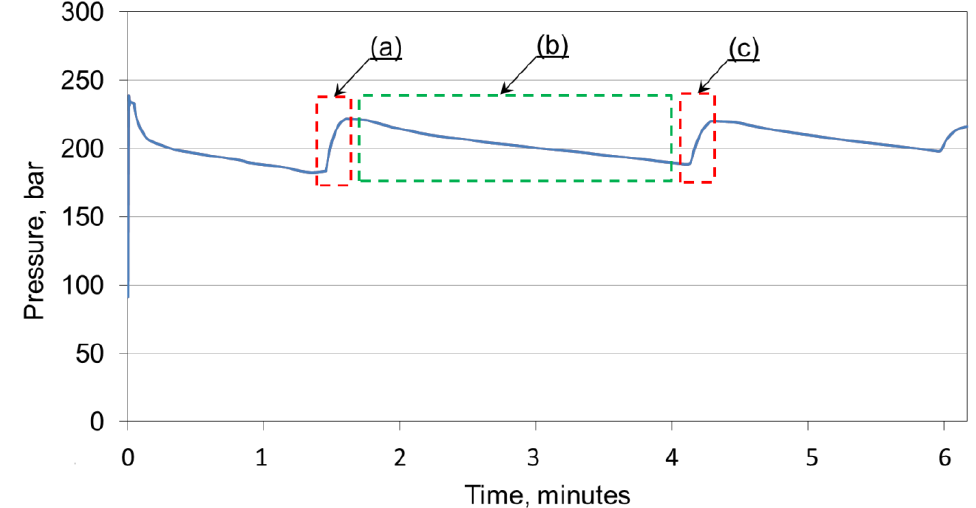
Figure 4. Stationary test of the double block charging function, where: (a) the charging time is 15.1 s; (b) the time of loss of the prop’s load capacity is 141.8 s; (c) the charging time is 9.6 s.